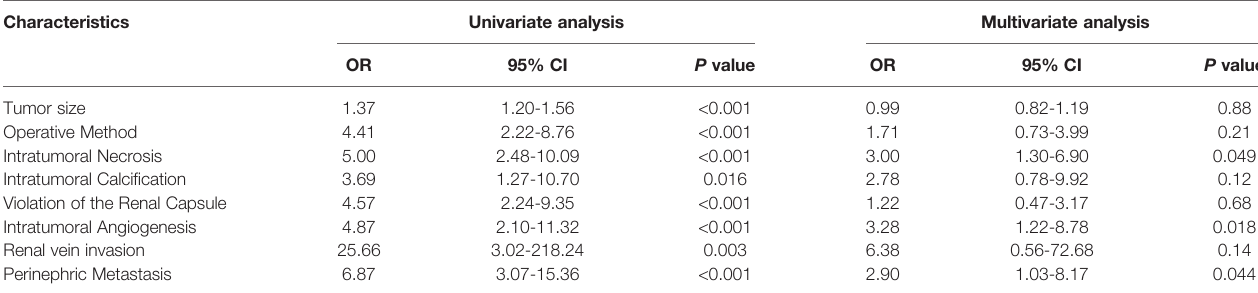
TABLE 2 | Univariate and multivariate logistic regression analysis of the clinic-radiological features in predicting the WHO/ISUP grade of CCRCC. Characteristics